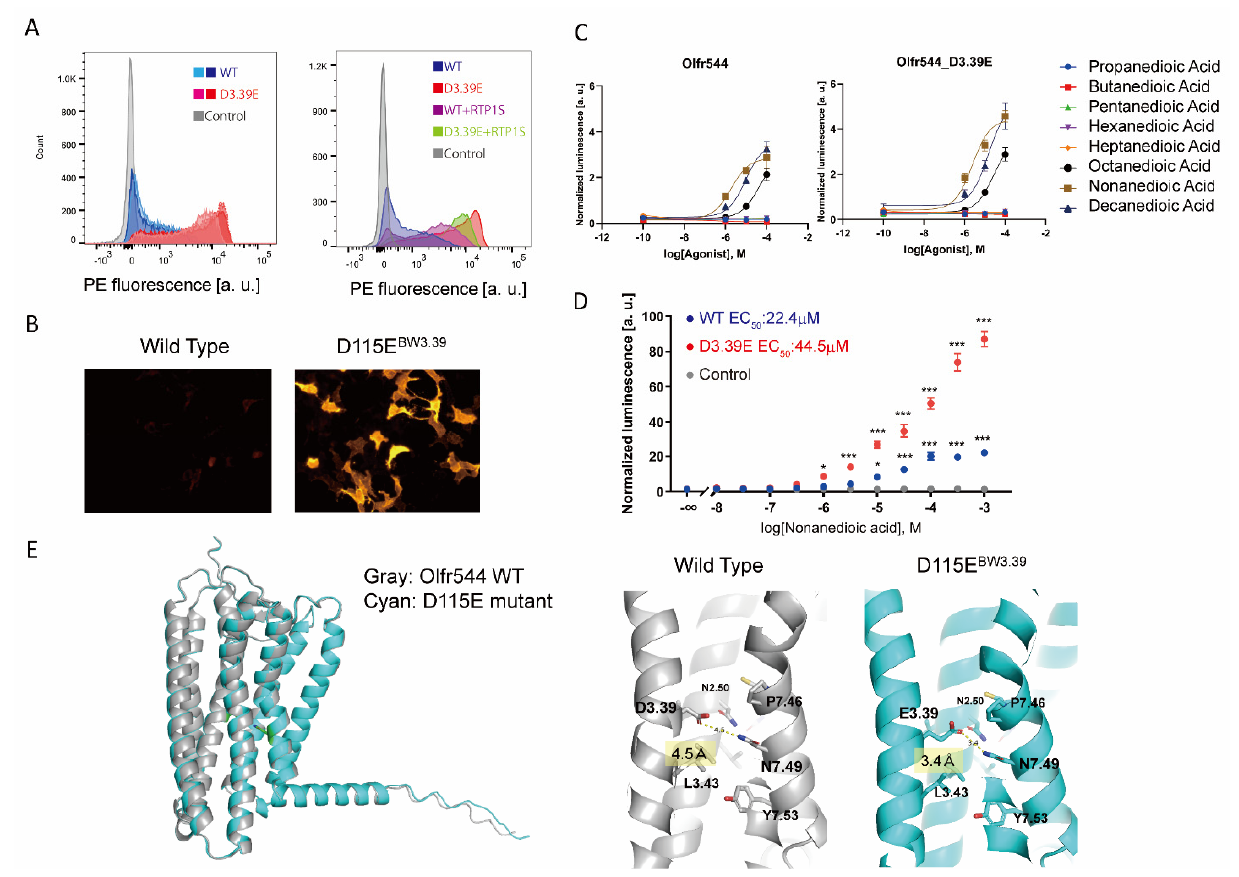
Figure 3. Detailed analysis of Olfr544 D115E BW3.39 ( A ) Cell-surface expression of the Rho-tagged ORs and D3.39E mutants. Each mutant was transfected into HEK293T cells, and the cell surface expression level was measured. X-axis: PE fluorescence, Y-axis: cell number. Left: Comparison between the WT and the D3.39E mutant. The results from two independent experiments are shown in the graph. Right: The effect of RTP1S co-expression of Olfr544 and D3.39E mutant. ( B ) Immunocytochemical image of Olfr544 and the D3.39E mutant stained with anti-Rho4D2 mouse antibody and PE-conjugated anti-mouse IgG goat antibody. ( C ) Agonist selectivity of Olfr544 and the D3.39E mutant for various dicarboxylic acids. Error bars indicate s.e.m (n = 3). ( D ) Dose response curve of Olfr544 and the D3.39E mutant to nonanedioic acid. Error bars indicate s.e.m (n = 3). Multiple comparisons were performed using one-way ANOVA followed by Dunnett’s test (* p < 0.05, *** p < 0.001). ( E ) Structural model of Olfr544 and the D3.39E mutant using Alphafold 2 prediction. It was predicted that the distance between the residue of 3.39 and N7.49 was 4.5 Å in the WT (D3.39) and 3.4 Å in the E3.39 mutant. Olfr544 belongs to the Class I OR family, and D3.39 is widely conserved in